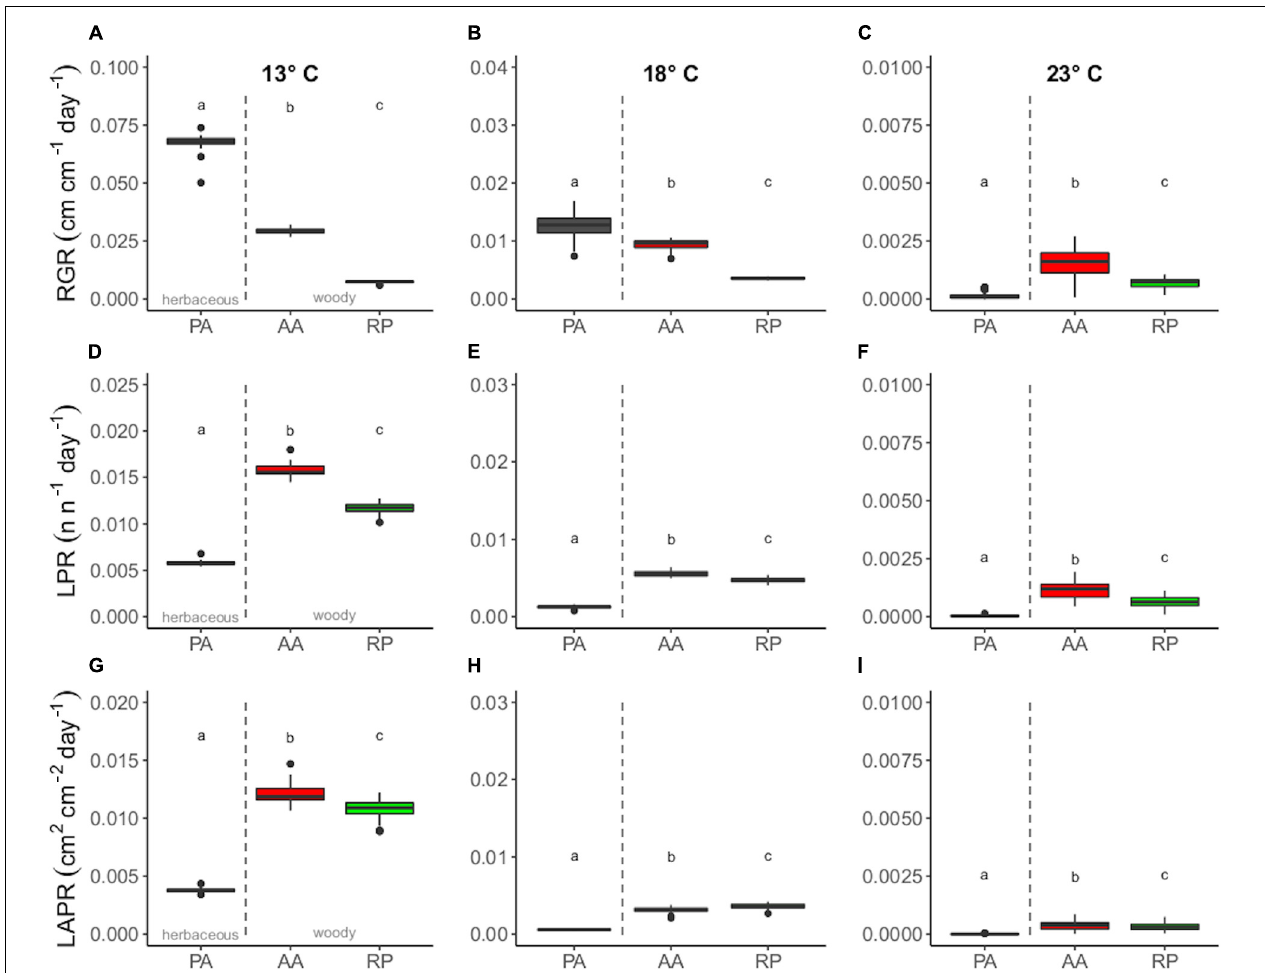
FIGURE 2 | Boxplot of panels (A–C) relative growth rate (RGR) (cm cm − 1 day − 1 ), (D–F) LPR (n n − 1 day − 1 ), and (G–I) LAPR (cm 2 cm − 2 day − 1 ) for Ailanthus altissima (AA), Phytolacca americana (PA), and Robinia pseudoacacia (RP) at three target temperatures. Differences among species were evaluated at 13–18 and 23 ◦ C. Different letters indicate significant differences (one-way ANOVA, p ≤ 0.05).